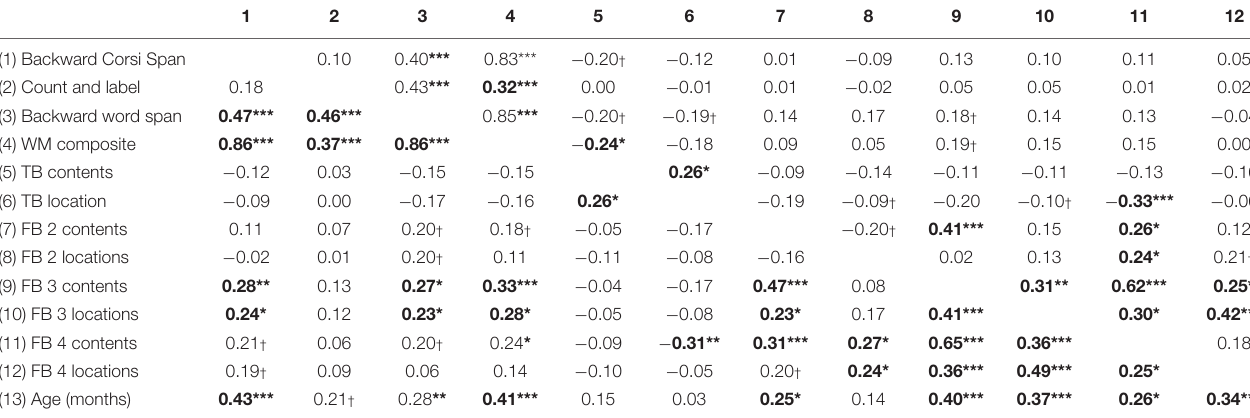
TABLE 2 | Correlations among study variables.